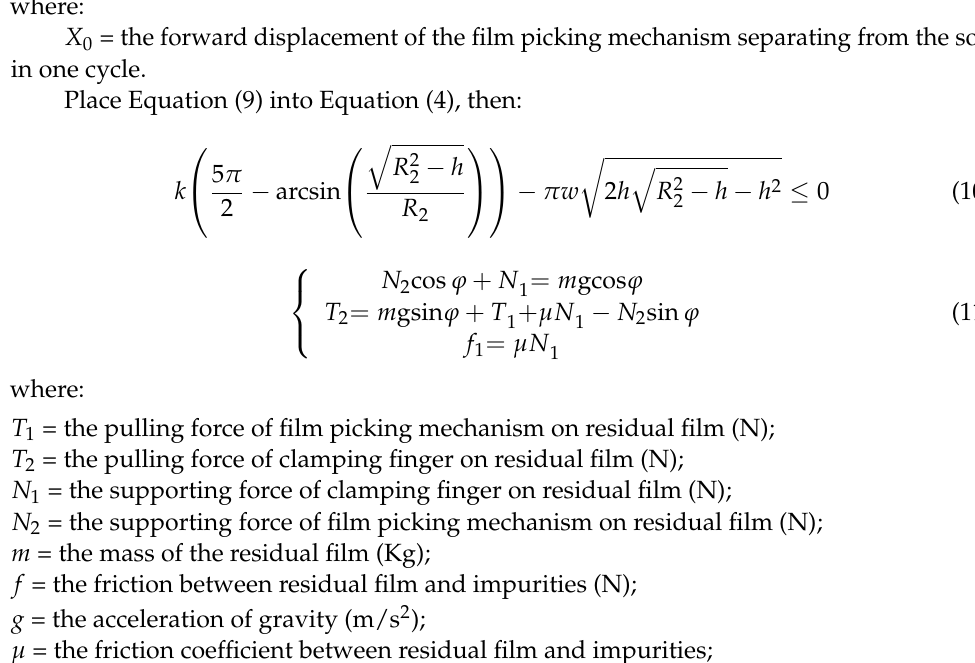
Figure 5. Schematic diagram of the movement trajectory of the finger in adjacent